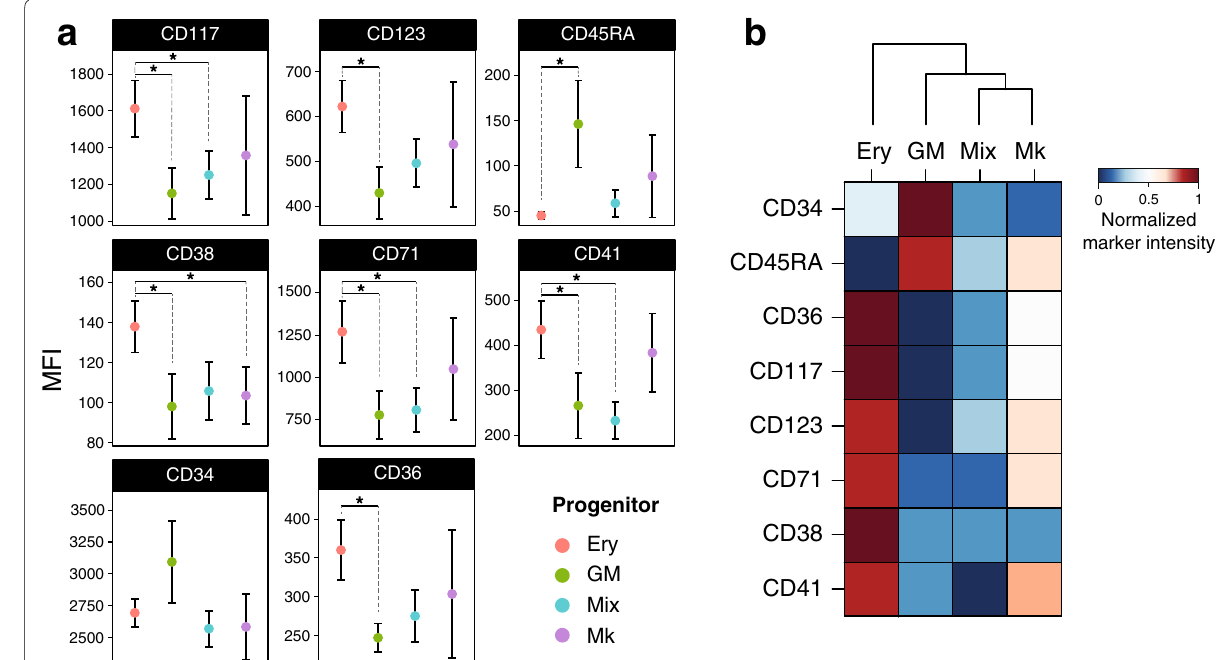
Fig. 2 Functionally defined progenitors have unique composite immunophenotypes. a Four colony types can be detected in our colony-assay system, erythroid (Ery), granulocytic/monocytic (GM), megakaryocytic (Mk), and a mixture of all (Mix), each representing one functionally distinct progenitor. For each type of progenitor the mean and standard error of the MFI for each of the markers used is displayed, demonstrating immunophenotypic differences for each progenitor (* t test, p < 0.1). b Hierarchical clustering based on the average, center-scaled intensity of each marker can resolve the relationships of the four